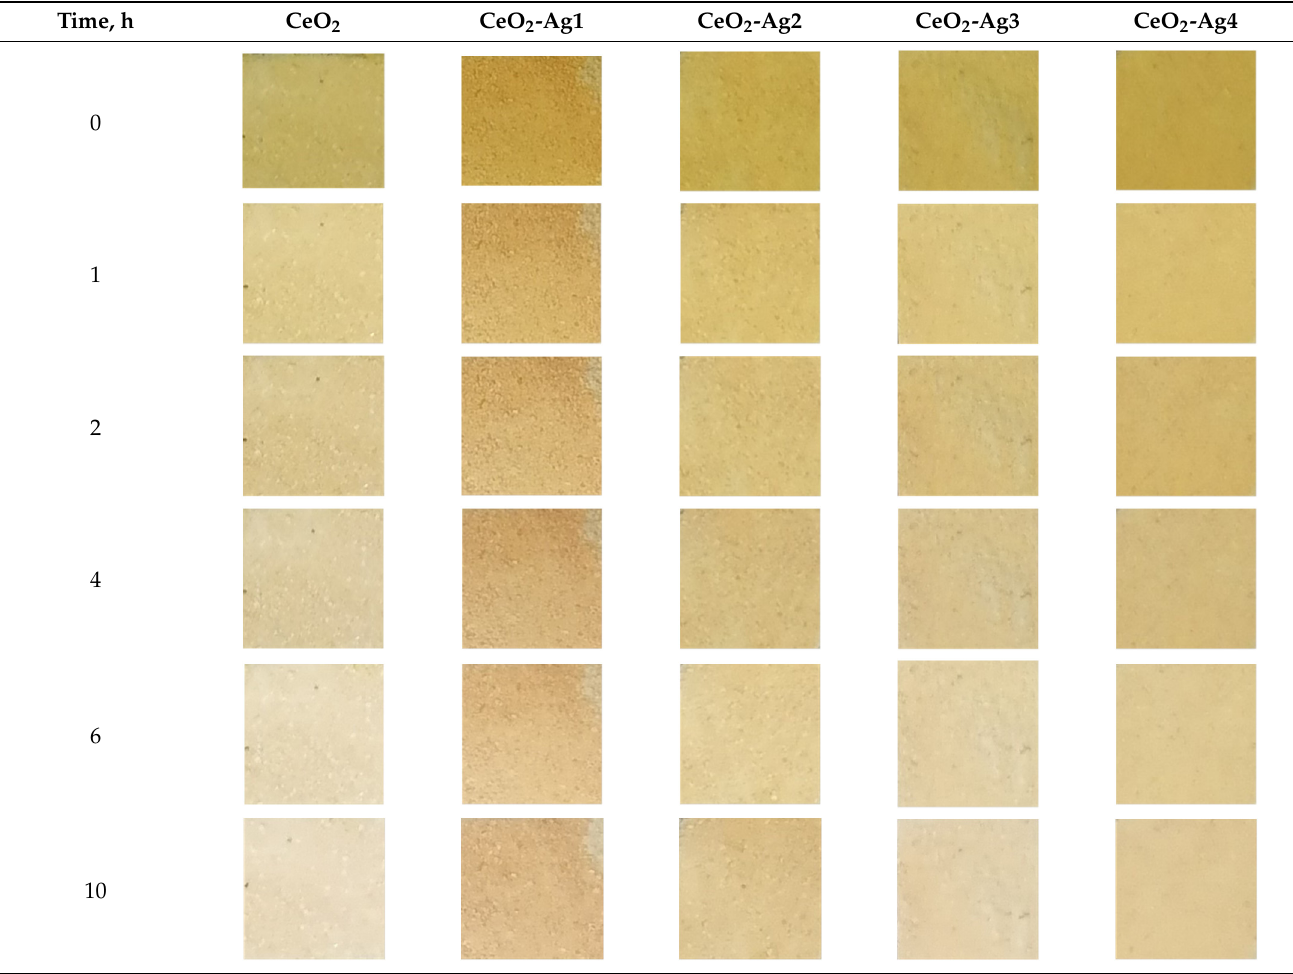
Table 3. Photos of the surface of the samples at di ff erent times of UV radiation exposure.